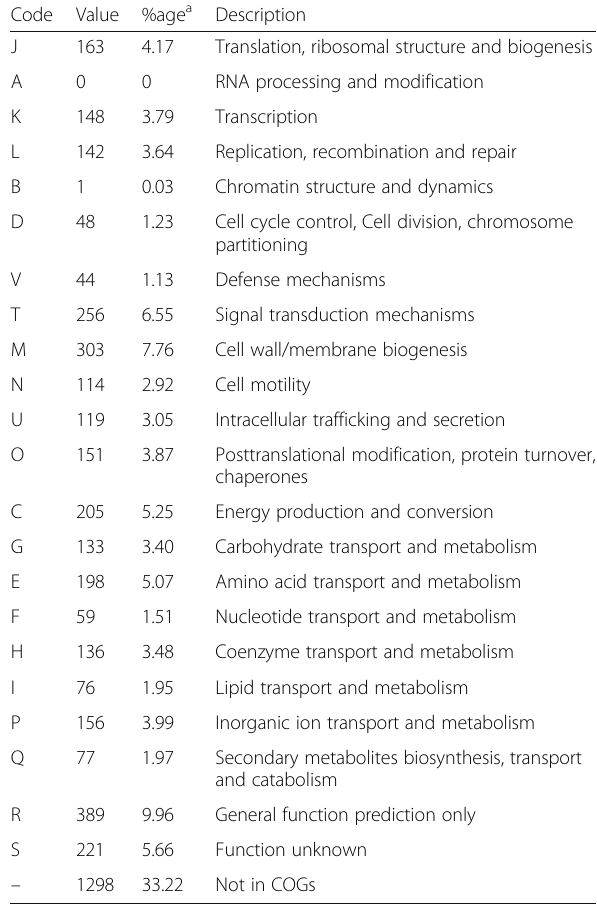
Table 4 Number of genes associated with general COG